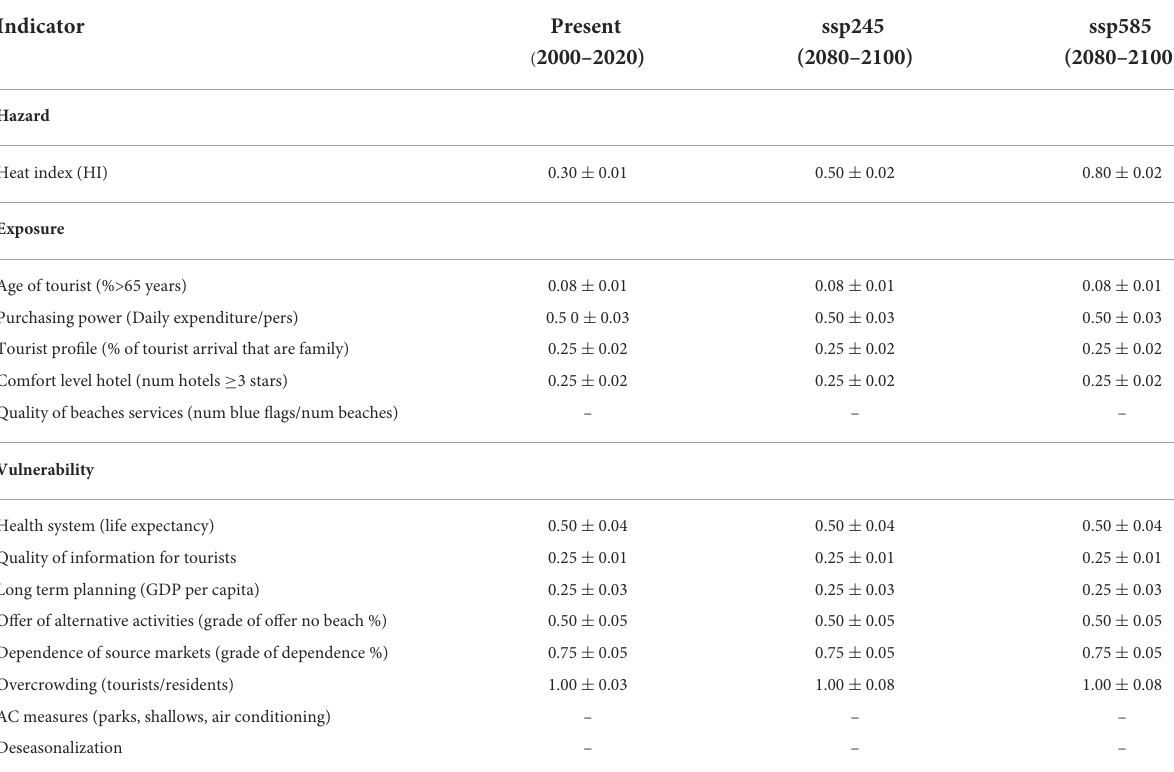
TABLE 1 List of indicators for the hazard, exposure, and vulnerability components and their respective normalized values and corresponding uncertainty.